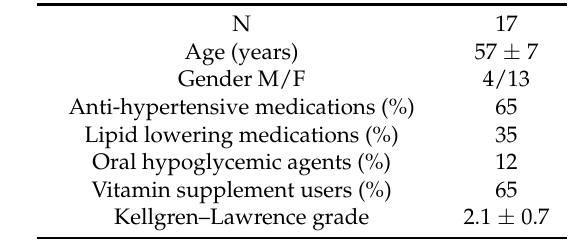
Figure 1. Study design. Table 2. Baseline characteristics.